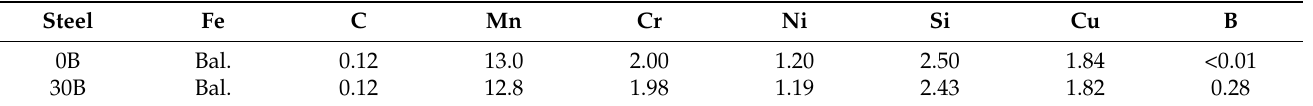
Table 1. Chemical compositions of the experimental steels (in wt.%). The C content was analyzed by using a carbon-sulfur analyzer (CS-2800) with an error of 3%. The Mn content was determined by titration with an error of 1%. The B content was analyzed by spectrophotometry using a 722SP spectrophotometer with an error of 5%. The content of Cr, Ni, Si and Cu was analyzed by using